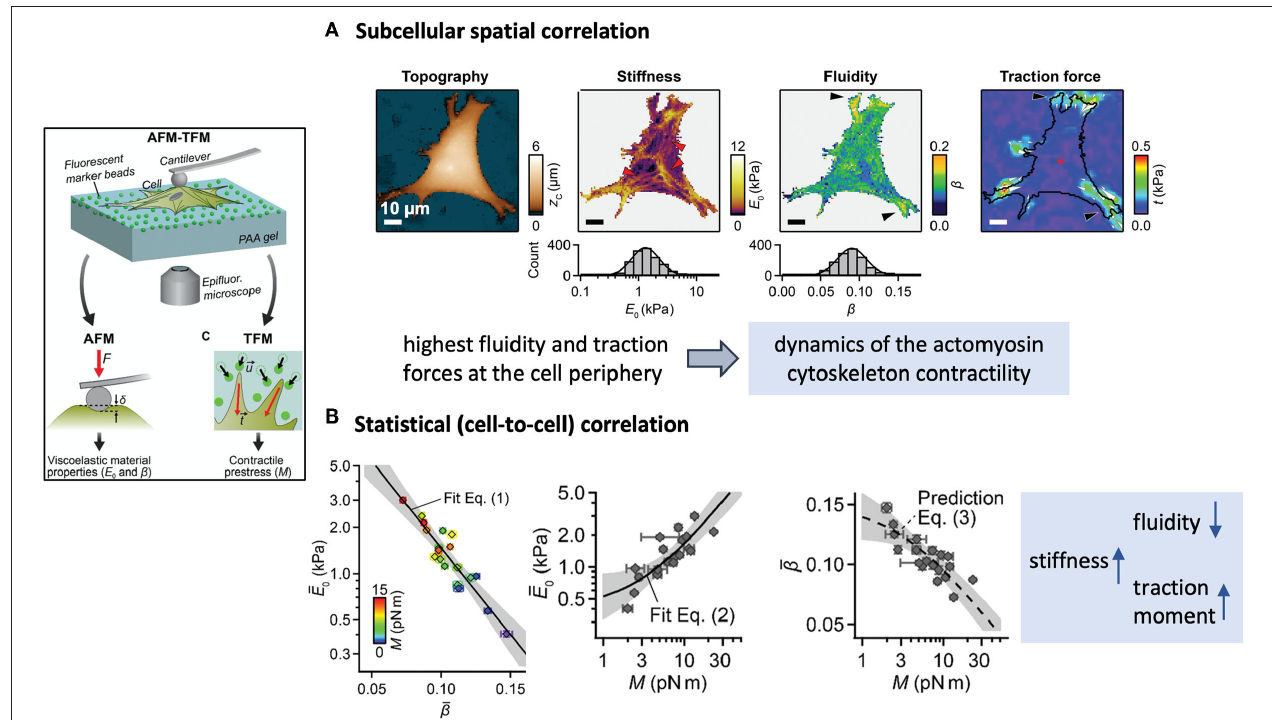
FIGURE 4 | Example of a scientific study based on the combination of an AFM and an TFM to find spatial and statistical correlations between cell mechanical parameters. The framed inset on the left outlines the experimental approach. (A) Multiparametric maps of a fibroblast showing examples of colocalization of areas of high traction activity with regions of high fluidity. (B) The average results show however that stiffer cells exert higher traction moments than more fluid cells. (Figures reproduced from Schierbaum et al., 2019 with permission of the Royal Society of